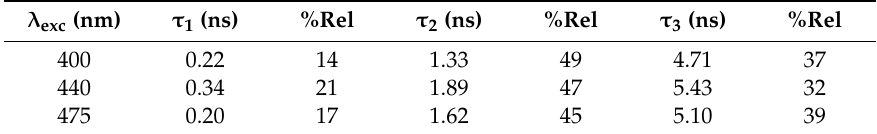
Table 2. Fit parameters of the decay kinetic curves excited at di ff erent excitation wavelengths for graphene quantum dots formed from oxacillin precursor (o-GQDs).